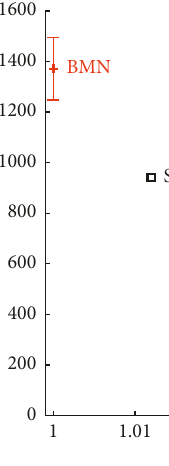
Figure 9: Ultimate strength as function of the warp yarn crimp for the specimens containing 3D-woven and noobed